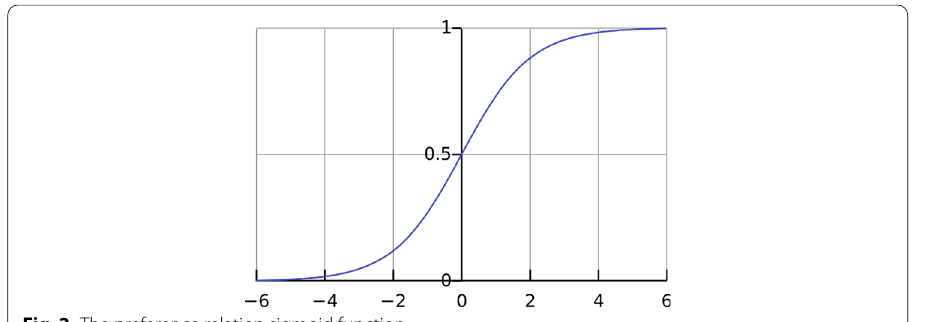
Fig. 2 The preference relation sigmoid